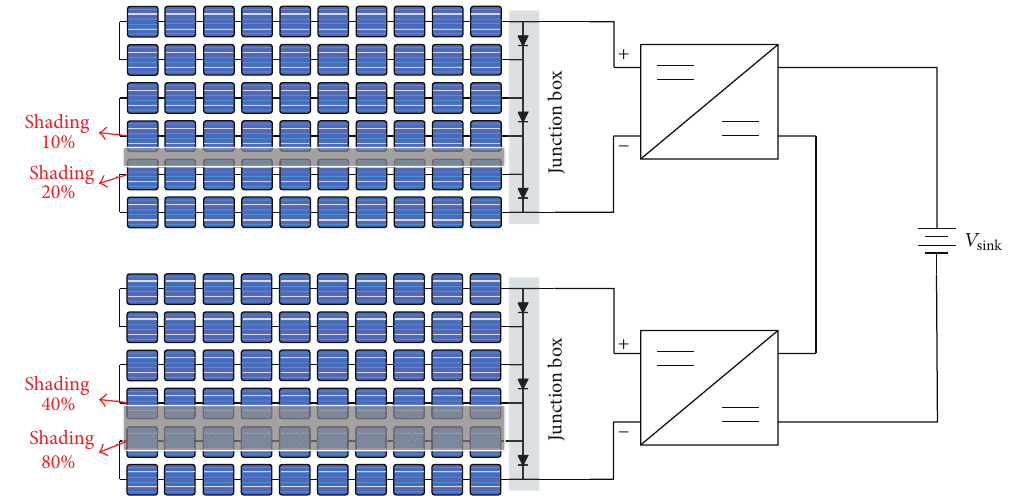
Figure 6: Two-panel distributed PV system under different shading